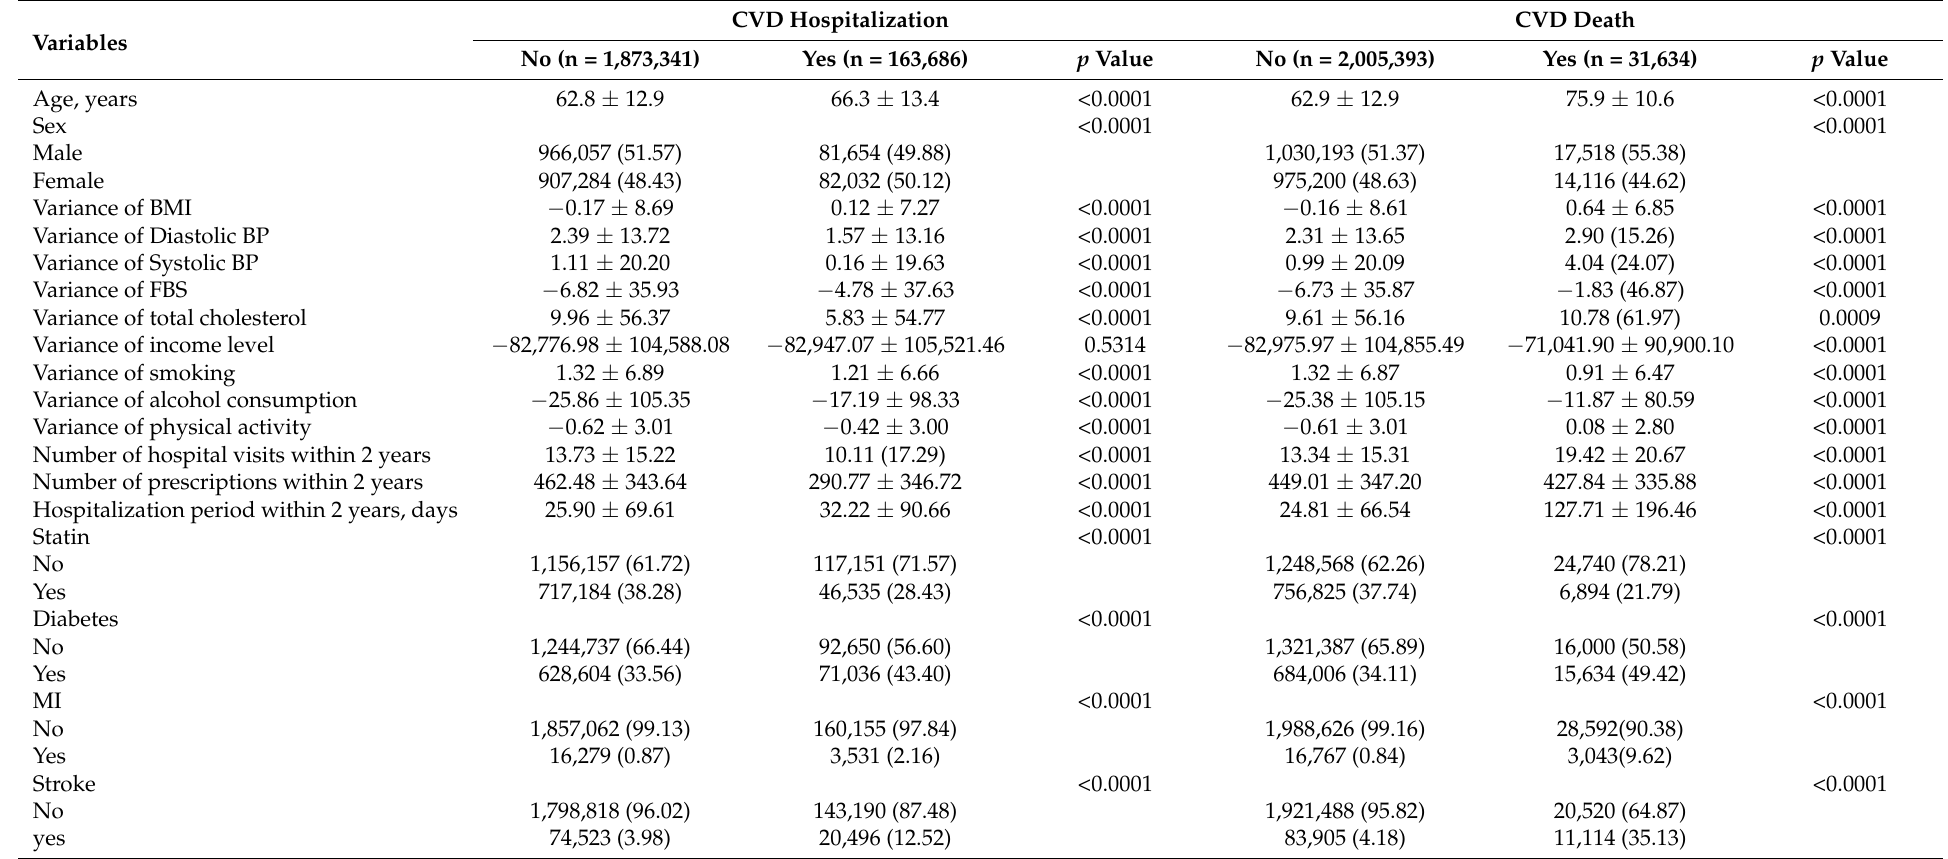
Table 1. Baseline characteristics of study participants in CVD hospitalization and CVD death